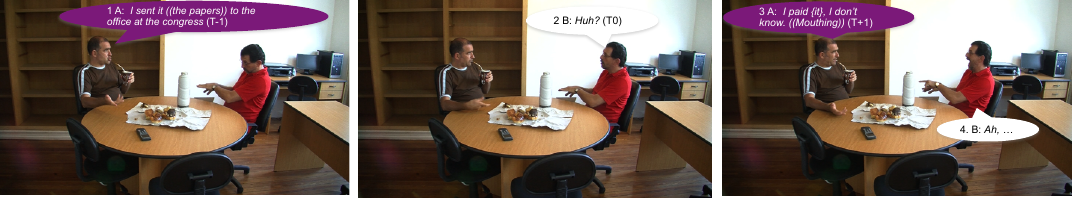
Figure 17. ‘Ah, …’ Person B (left) releases his body position (line 4) by pointing toward Person A and opening his mouth wide giving an uptake after the resolution of the